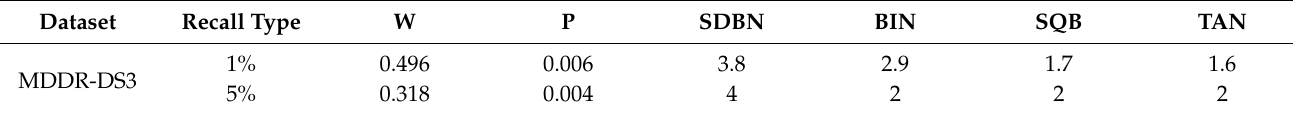
Table 11. The results of Kendall W test for DS1 and DS2